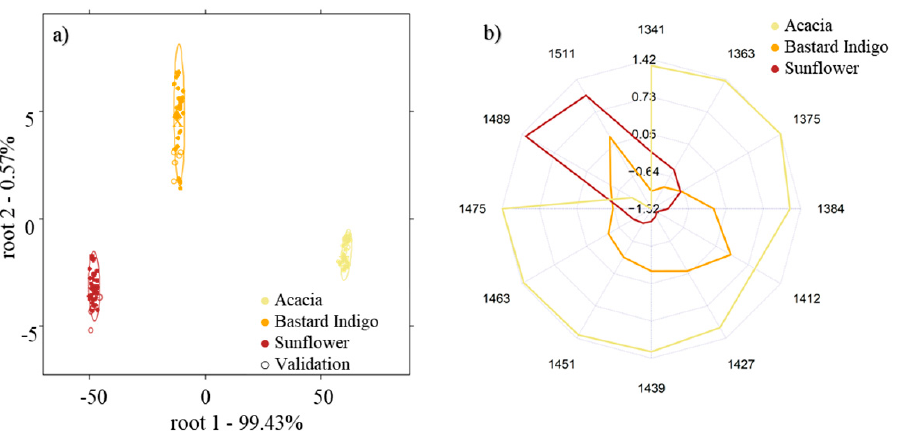
Figure 1. Differentiation of the botanical origin of the three control honeys: ( a ) PCA-LDA score plot for the discrimination of the botanical origin and ( b ) aquagrams of the honey samples of different botanical